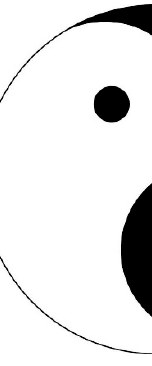
Figure 1. represents “Tai Chi” (Tai Chi 2021) Figure 1. Represents “Tai Chi” (Tai Chi